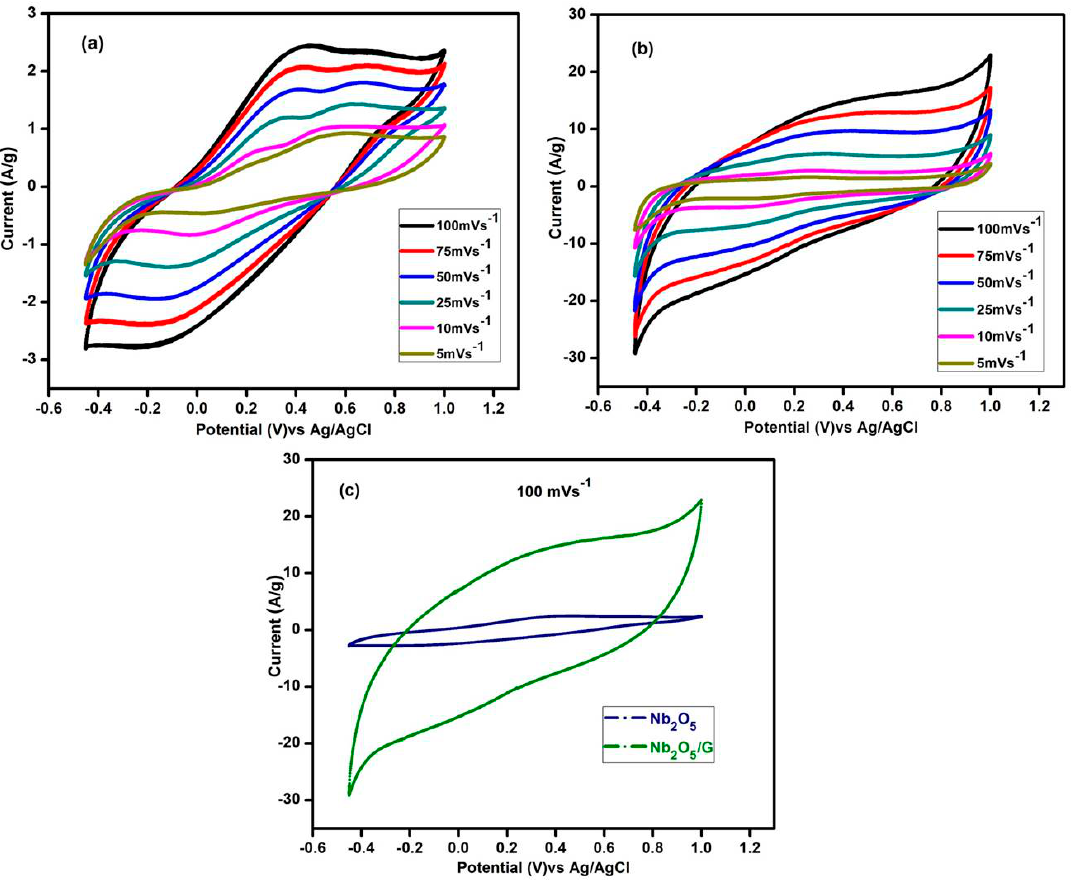
Figure 9. Cyclic voltamograms of ( a ) Nb 2 O 5 , ( b ) Nb 2 O 5 /G nanocomposite at different scan rates, and ( c ) comparison of CV curves of Nb 2 O 5 , and Nb 2 O 5 /G at a scan rate of 100 mVs − 1 .